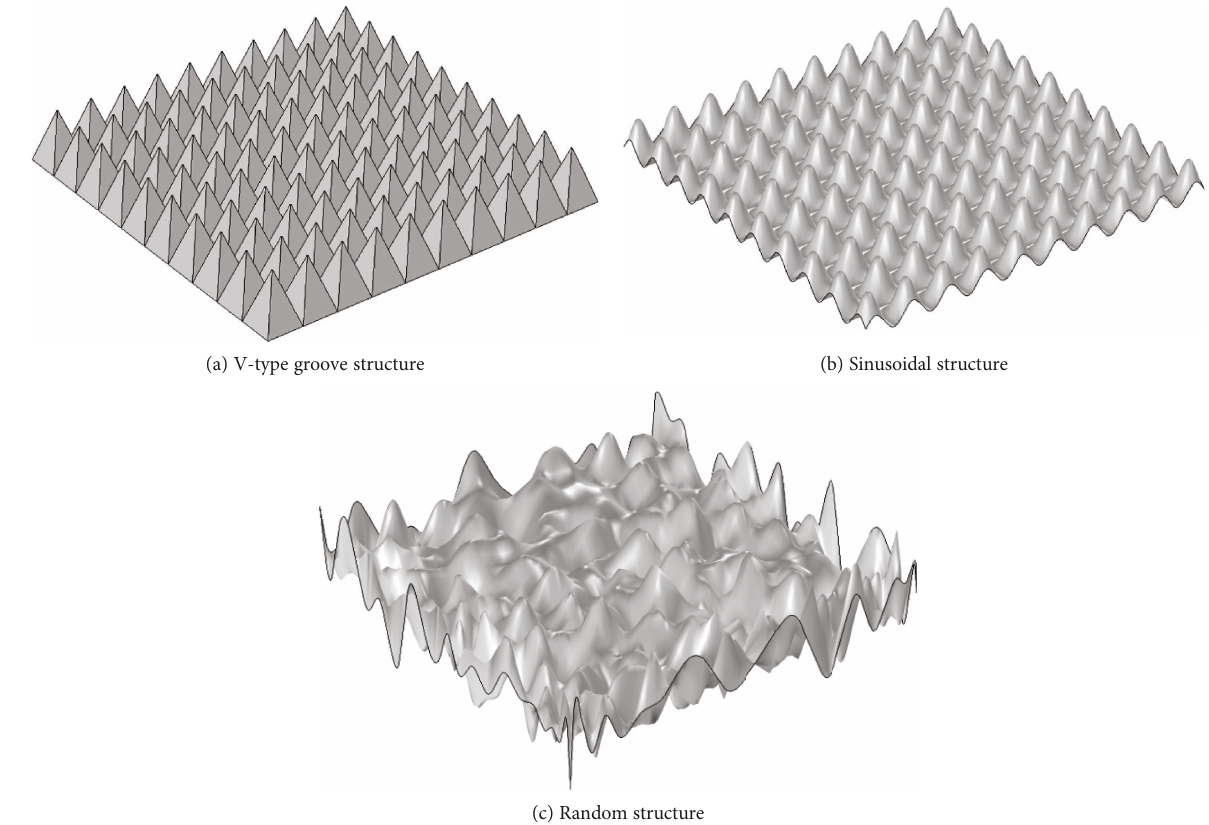
Figure 3: Three kinds of surface Table 1: Simulation parameters.